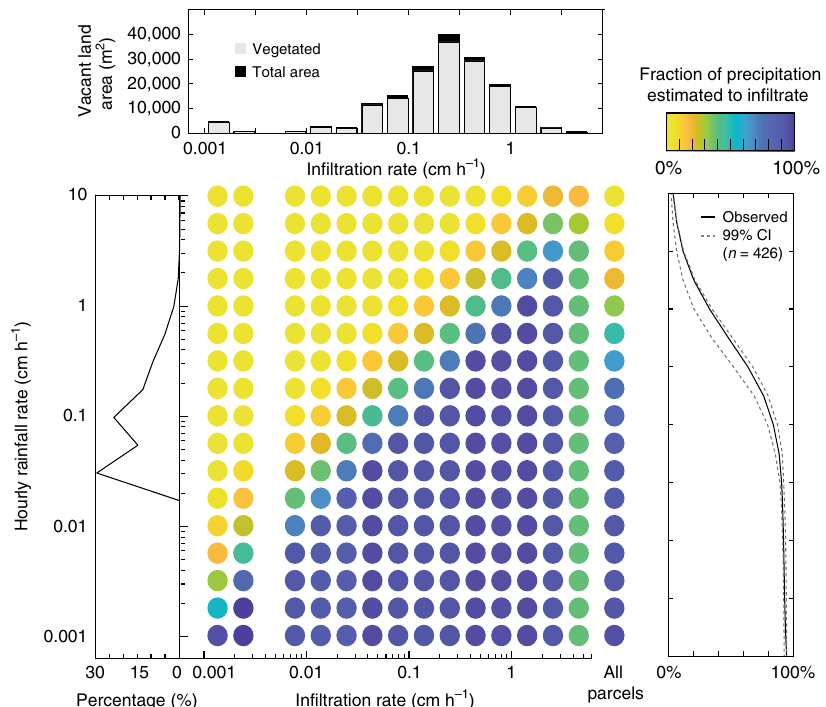
Fig. 2 Rainfall detention capacity. Visualized as the fraction of hourly precipitation (histogram for 21 years of warm-season precipitation) estimated to in fi ltrate ( n = 514) as a function of in fi ltration rate and pervious lot area. Con fi dence intervals (99%) show the impact of measurement uncertainty for a subset of sites ( n = 426; Supplementary Figs. 10 and